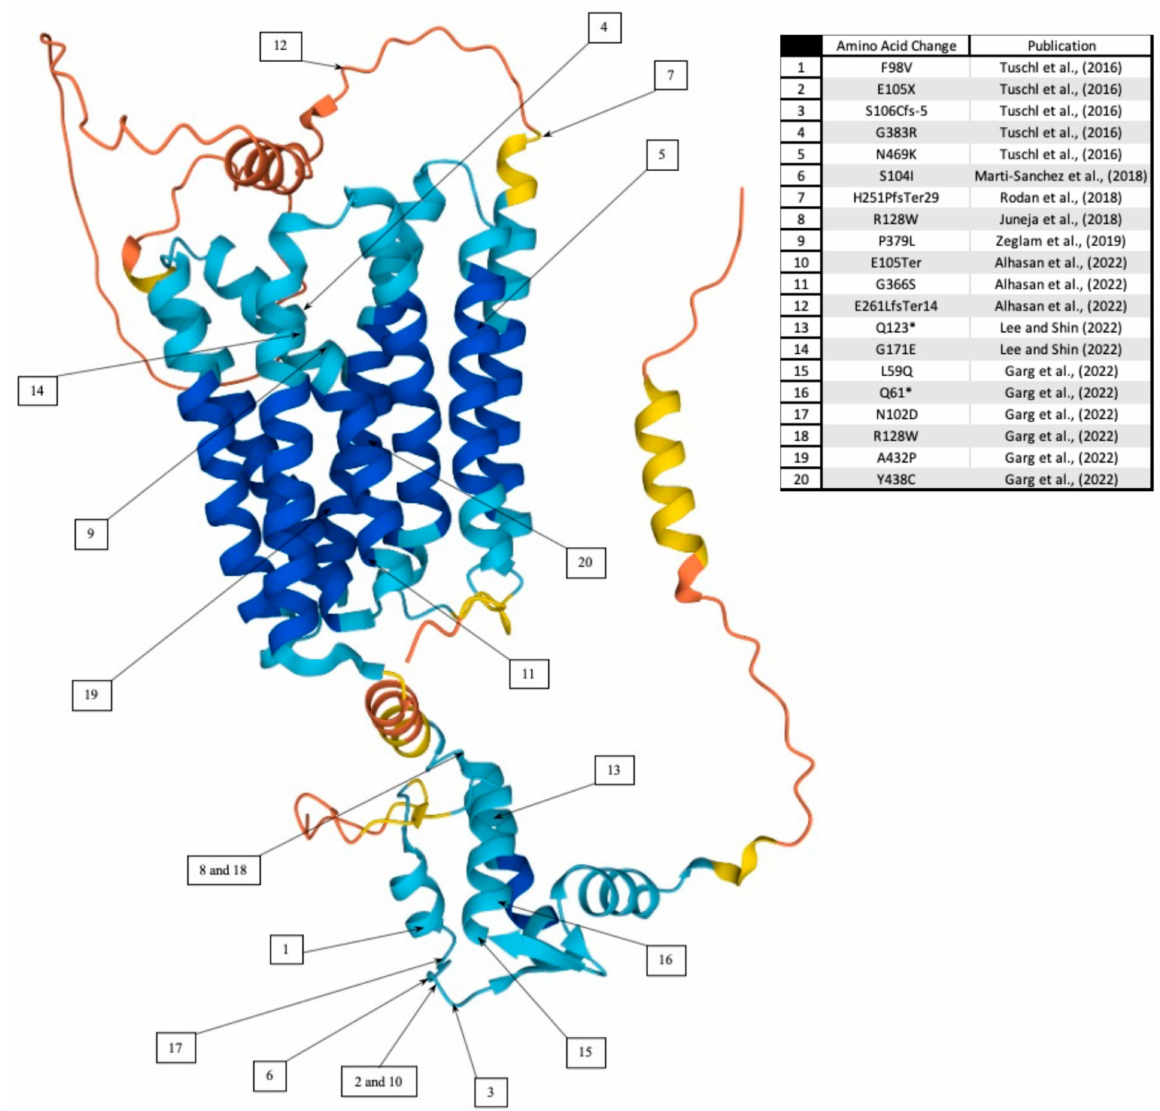
Figure 1. The protein structure of SLC39A14. The 3D structure was obtained using AlphaFold [31] (AF-Q15043-F1). Corresponding mutations and related work are indicated within the accompanying number table. Color gradient indicates model confidence (blue > 90; cyan 70–90; yellow 50–70; orange < 50). (See Refs.